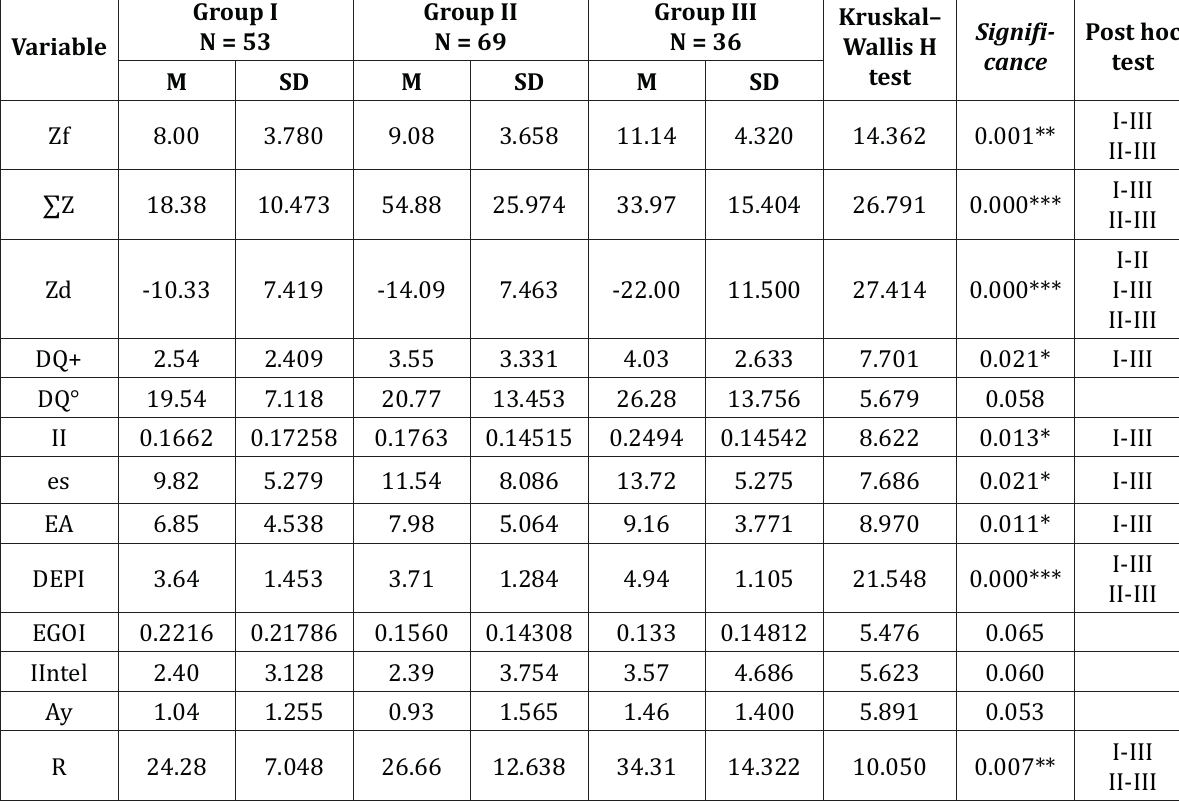
Table 1. Comparison of three groups of examinees in terms of the selected variables.